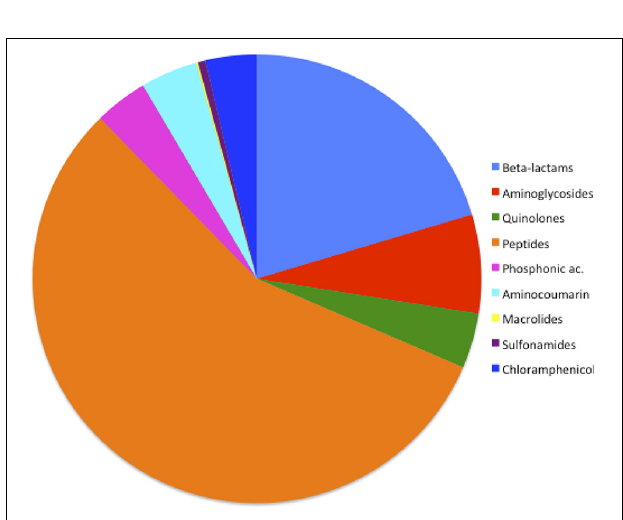
FIGURE 3 | Frequency of ARGs according to the antibiotic class in Serratia spp.